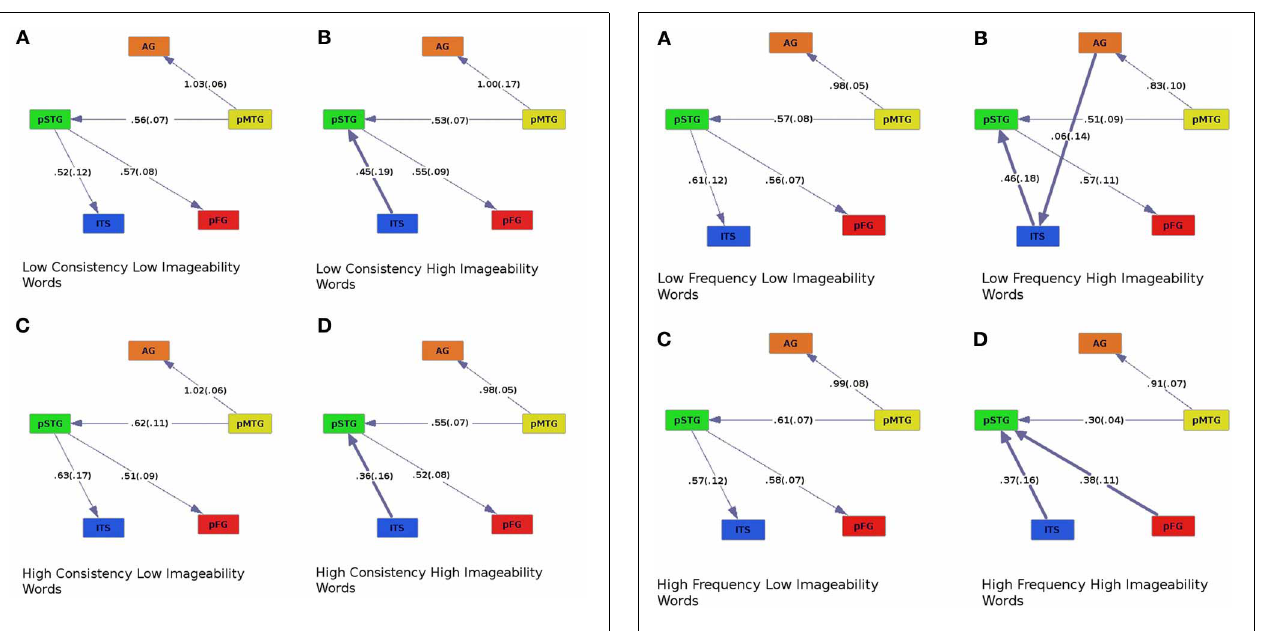
FIGURE 4 | Effective connectivity results for high (C,D) and low (A,B) levels of word frequency crossed with high (B,D) and low (A,C) levels of imageability. Colors and numbers are as in previous